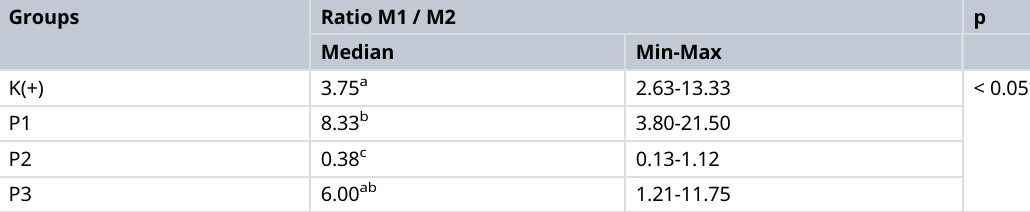
Table 6. M1 / M2 ratio in K(+), P1, P2 dan P3. Groups